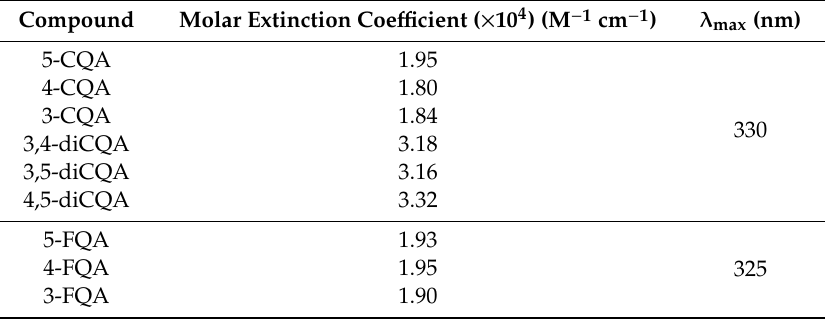
Table 5. Molar extinction coe ffi